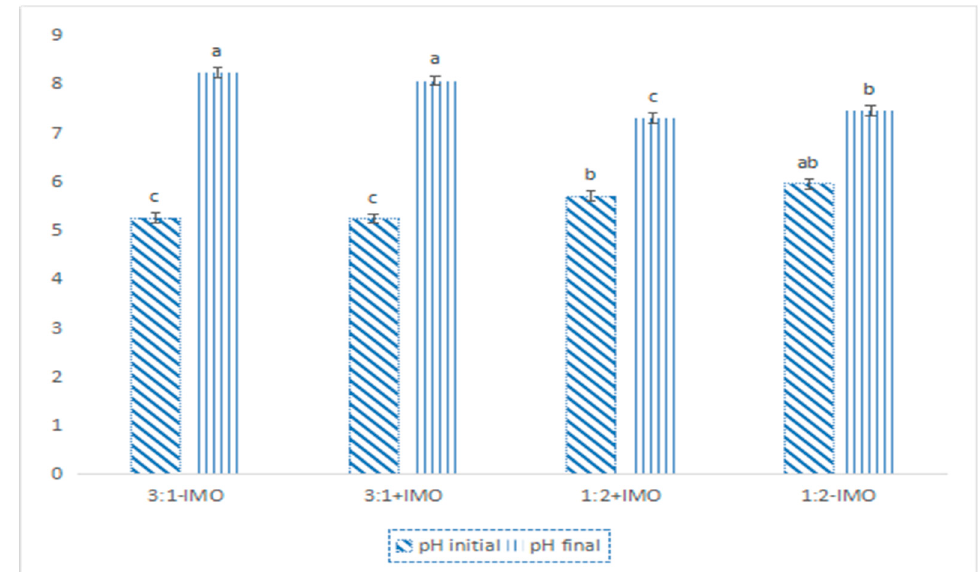
Figure 2. Initial and final pH of composts made with and without the addition of IMO. Footnote: Similar letters on the bar chart across the treatments indicate not significantly different at p = 0.05.